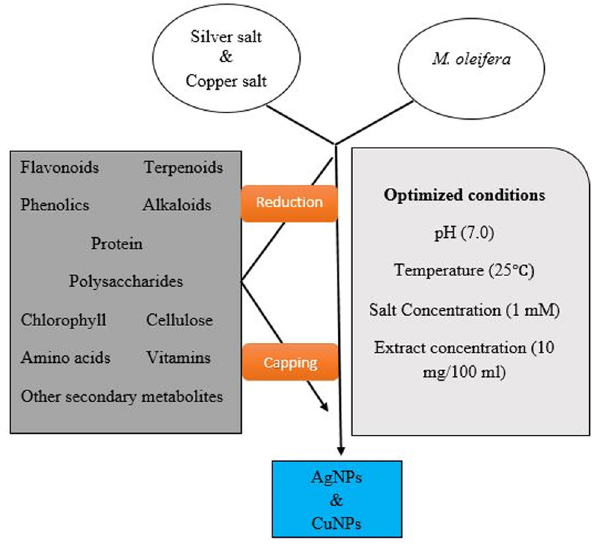
Figure 1: Flow chart for the possible synthesis of silver and copper NPs.